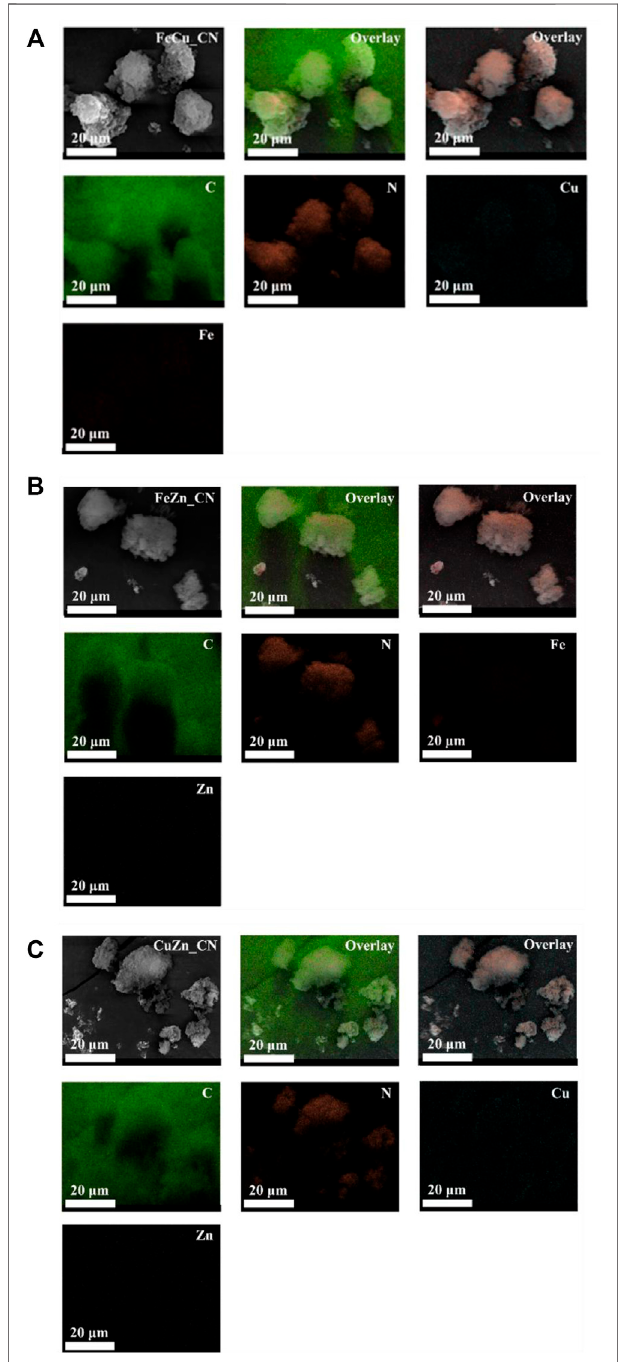
FIGURE 3 | XRD patterns of undoped CN and metal-doped CN, and an enlarged view of the (002) peak.